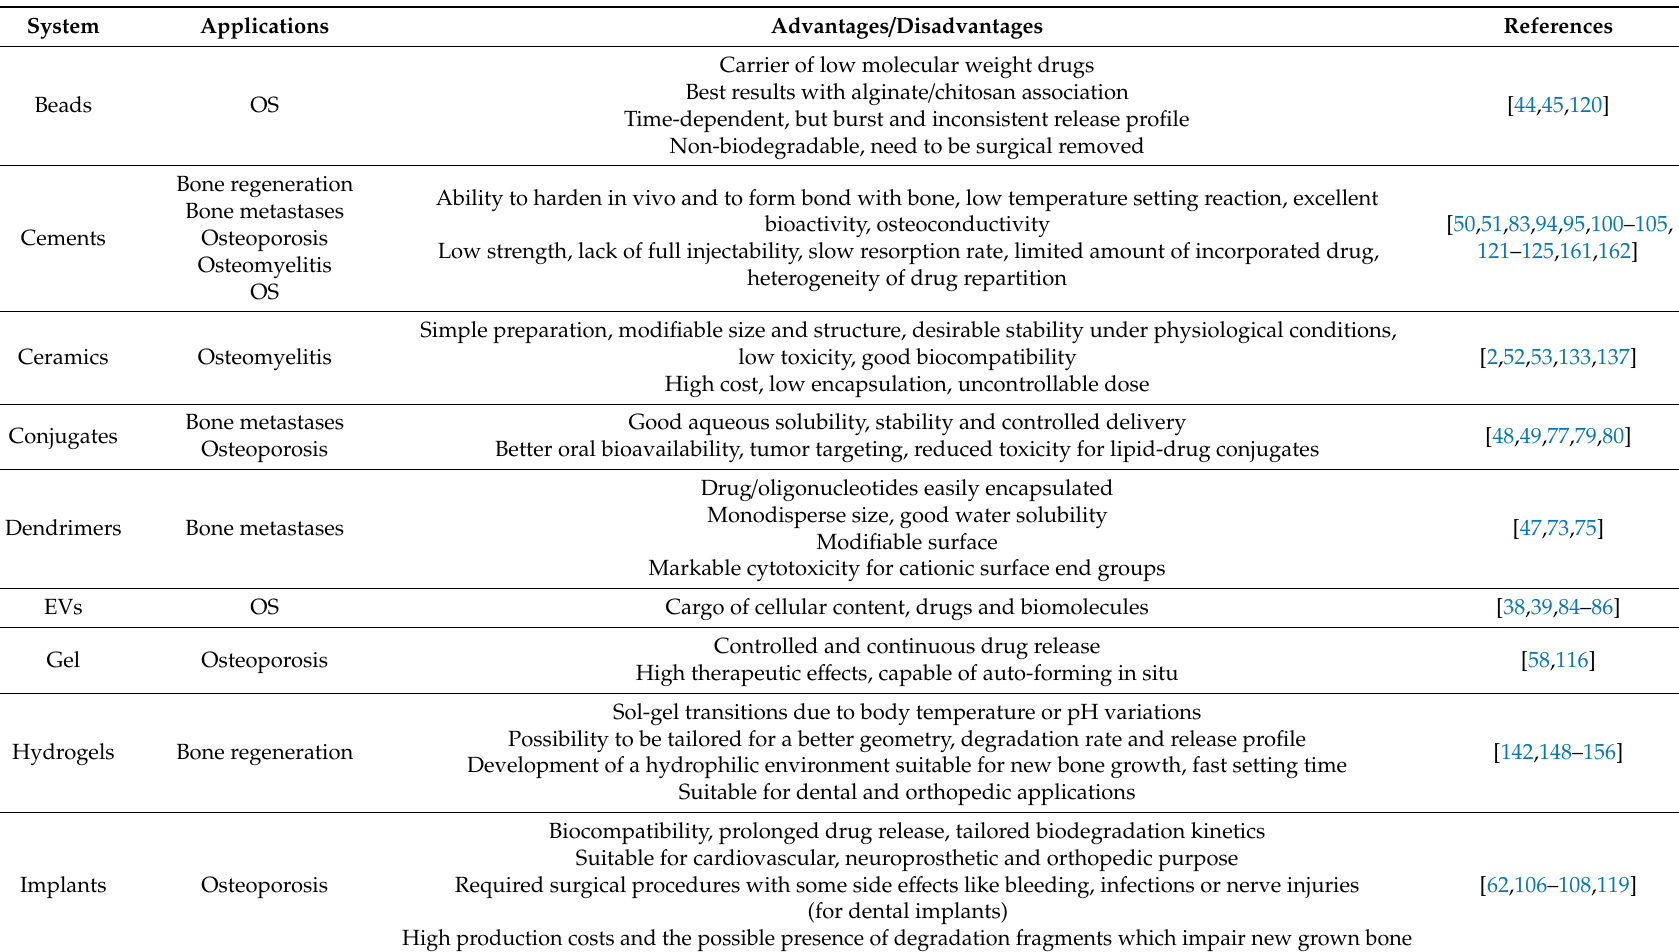
Table 9. Summary of the studies on bone drug delivery examined in this